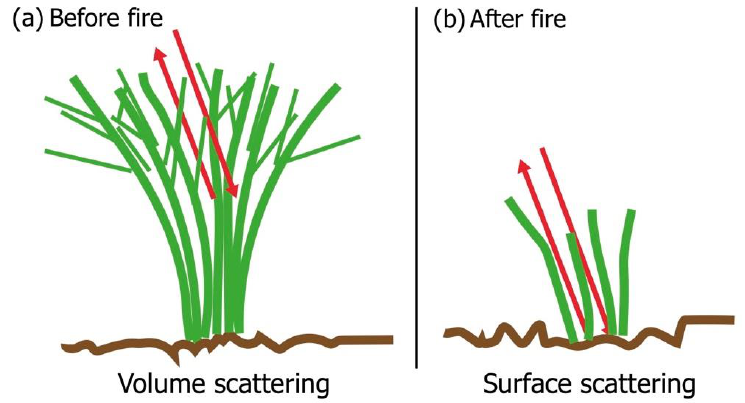
Figure 3. Dominant radar backscattering mechanisms in tundra environment. ( a ) volume scattering within tussock-forming sedges before a fire, ( b ) surface scattering from rougher ground after a fire.